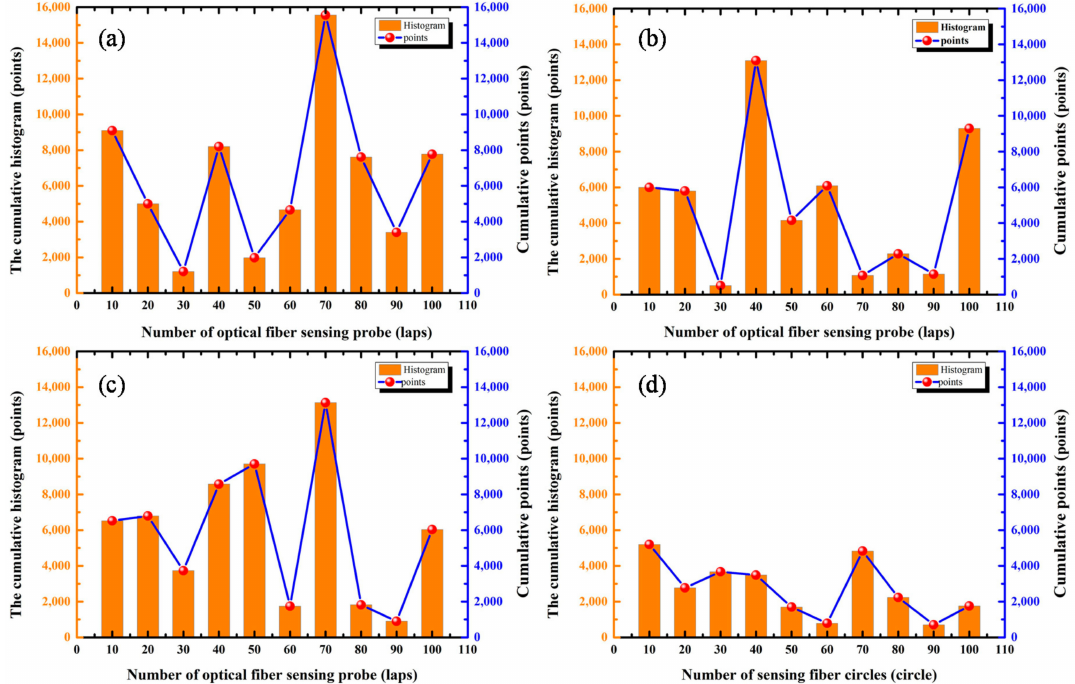
Figure 15. Statistical histogram of the frequency of ( a ) 7.8 kHz, ( b ) 28.9 kHz, ( c ) 37.6 kHz and ( d ) 57.6 kHz with the number of sensing fiber